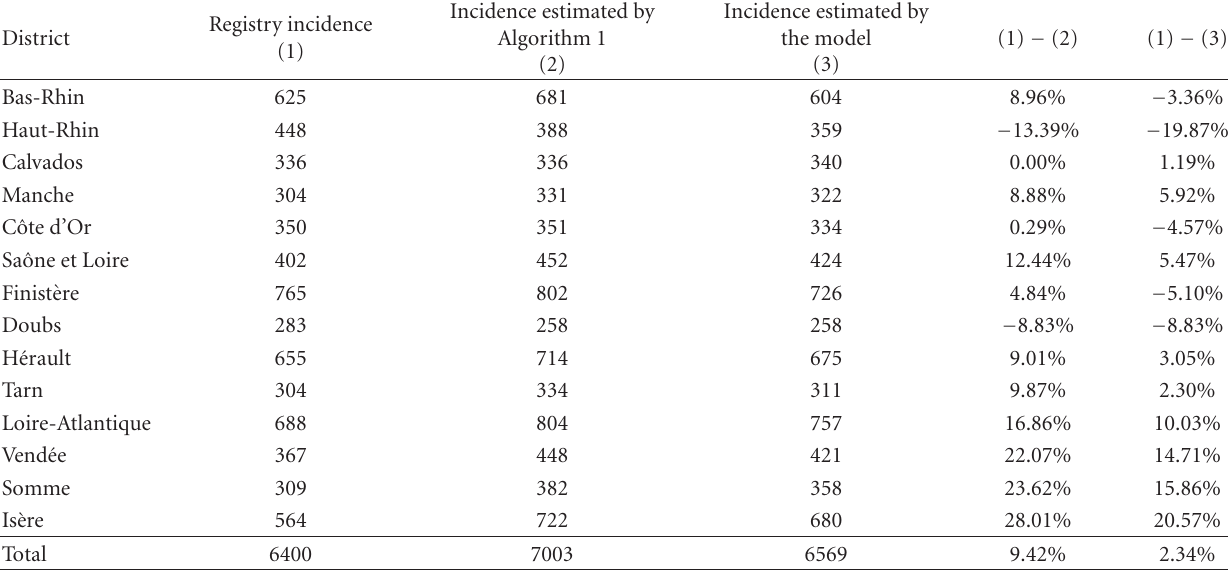
Table 5: Colorectal-cancer incidence comparison between results of predictive model and registry